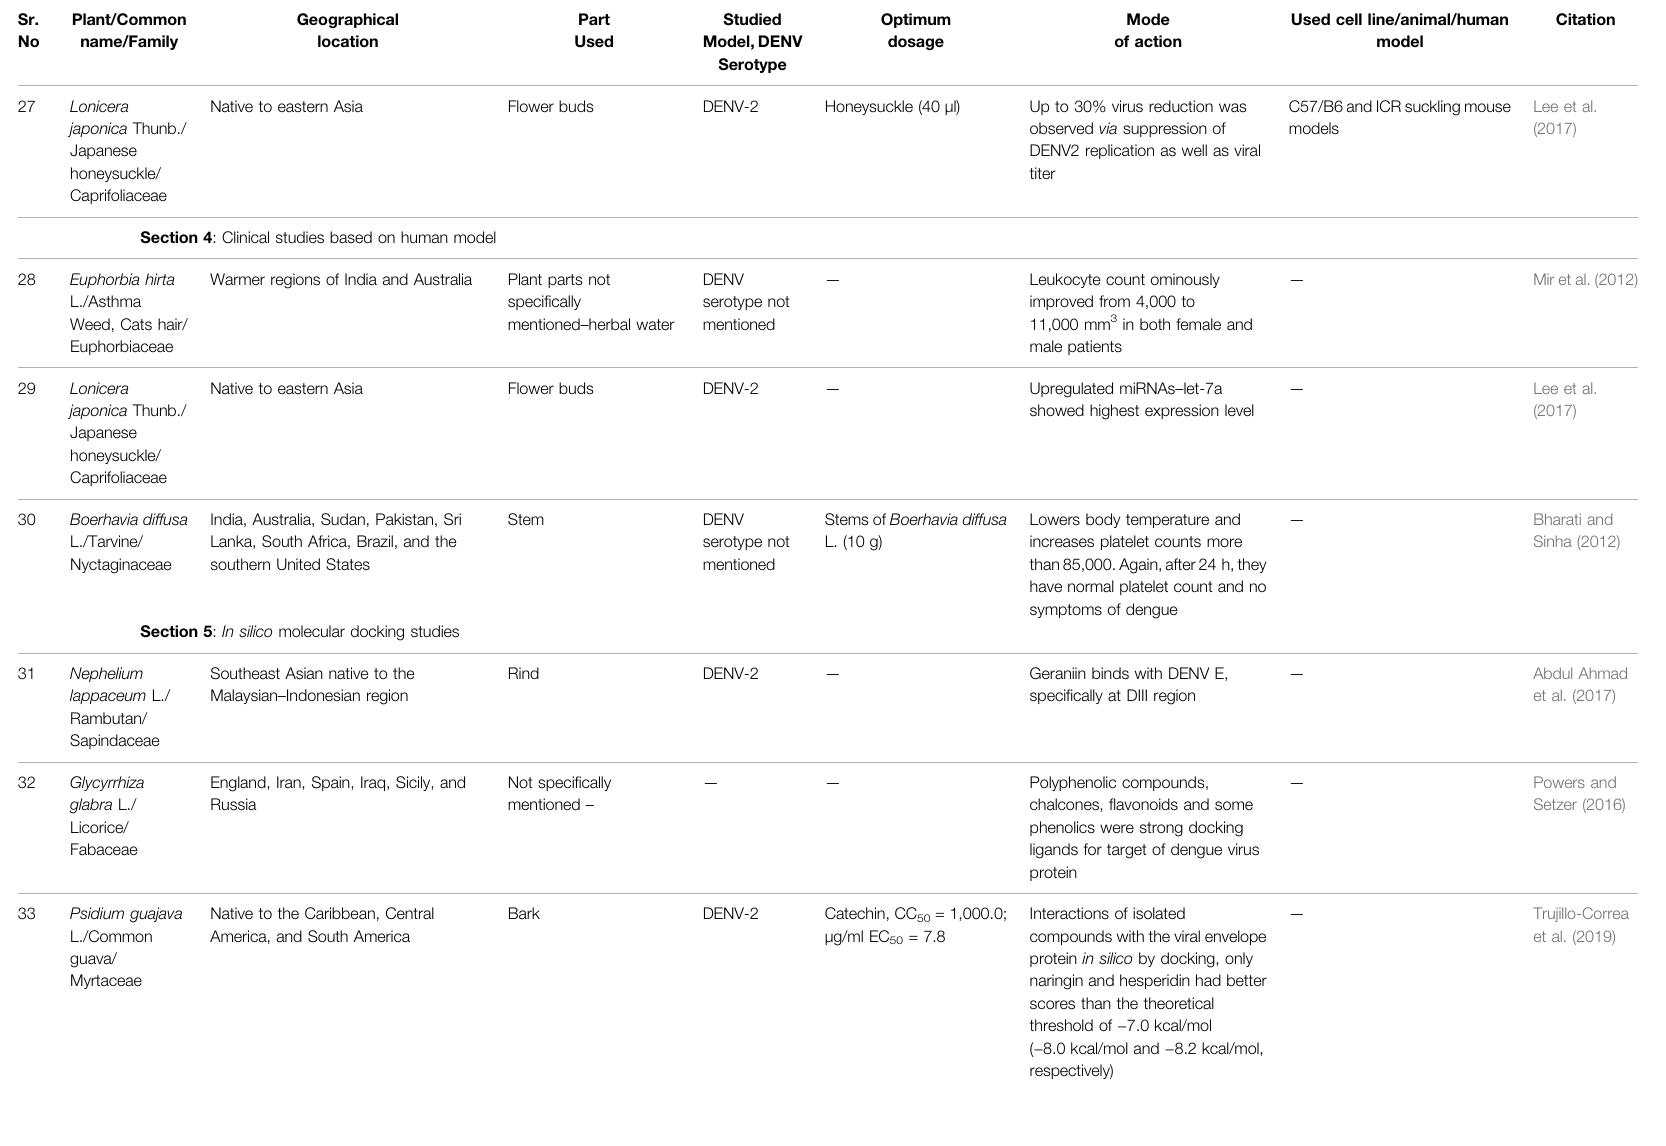
Section 4 : Clinical studies based on human model